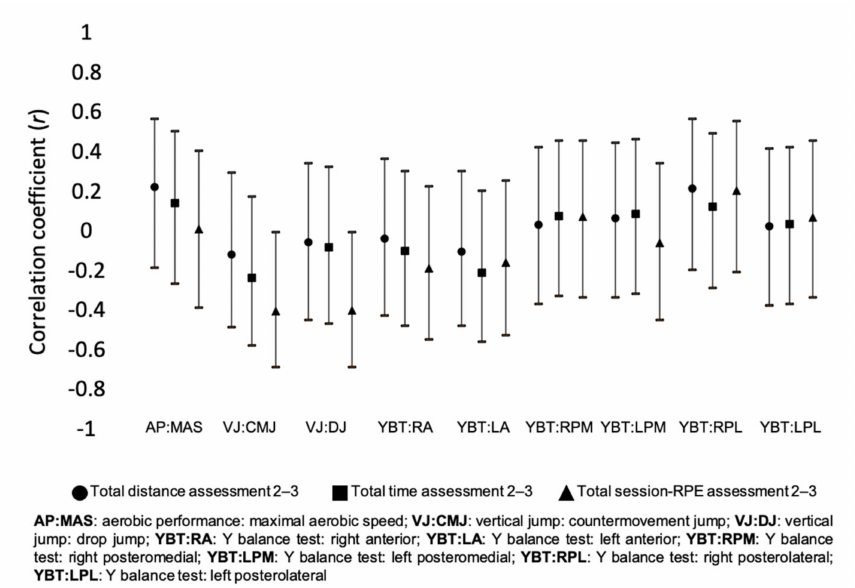
Figure 4. Correlation of accumulated training load variables between assessment 2 and 3.